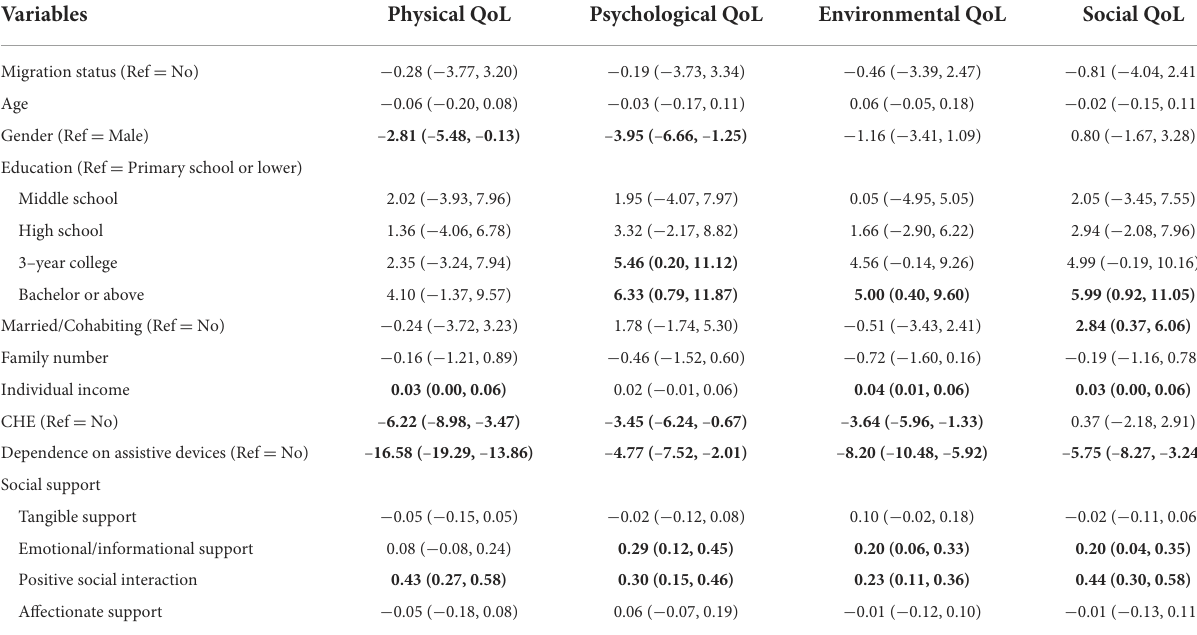
TABLE 5 Direct effects of migration on the four dimensions of QoL for urban adults with rare